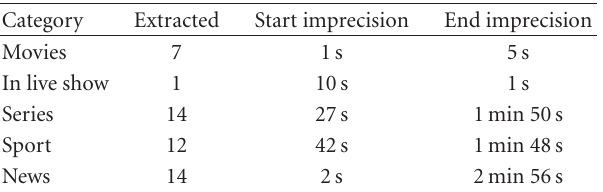
Table 9: Accuracy per category of extracted programs by DealTV from TVTest